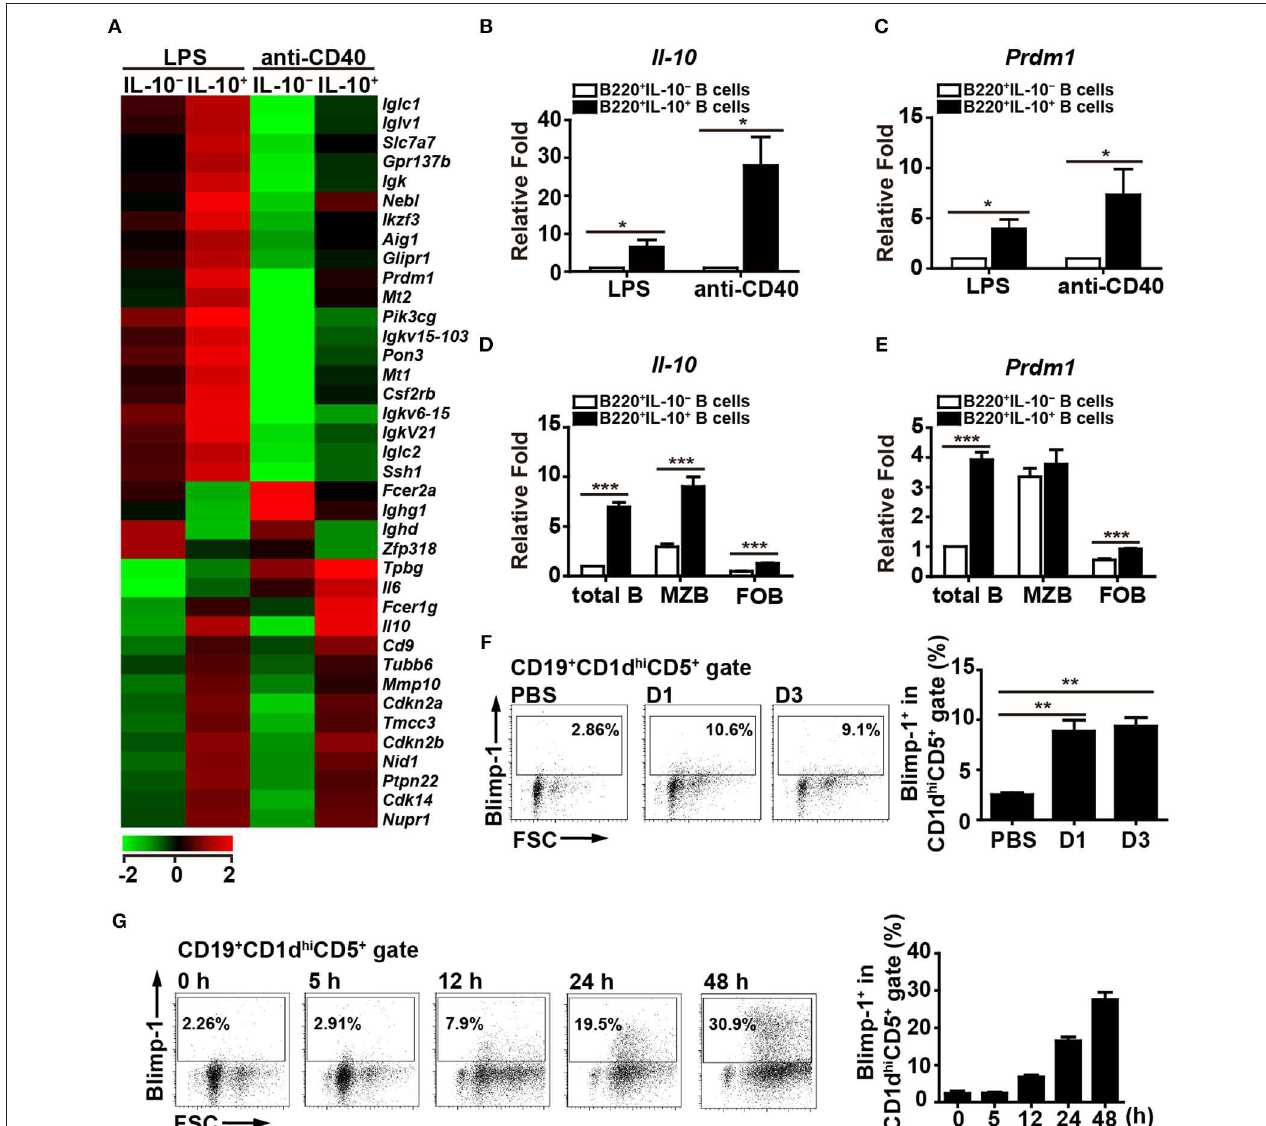
FIGURE 1 | Blimp-1 expression in Bregs. (A) IL-10 + B cells and IL-10 − B cells were purified from C57BL/6 mouse splenocytes and then stimulated with LPS (10 µ g/ml) or anti-CD40 antibody (2 µ g/ml) for 48h, after which their mRNA expression profiles were analyzed by microarray. The resulting clustering heat map diagram shows the fold changes in differentially expressed genes with changes of > 1.8-fold after stimulation. Data are the mean values from two experiments. (B,C) RT-qPCR analysis of Il-10 (B) and Prdm1 (C) mRNA levels in IL-10 + B cells and IL-10 − B cells isolated from mouse splenocytes. Data are the mean ± SEM ( n = 3–5 mice